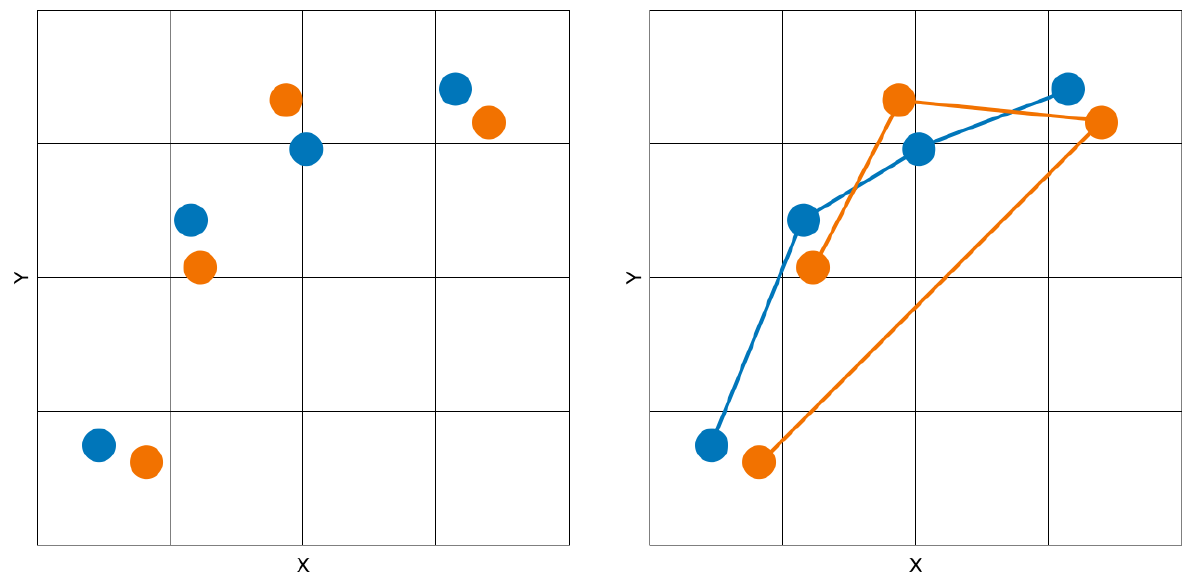
Figure 3. The same points expressed without a path sequence prepared for a Hausdorff distance calculation ( left ) and with a path sequence for a discrete Fréchet distance calculation ( right